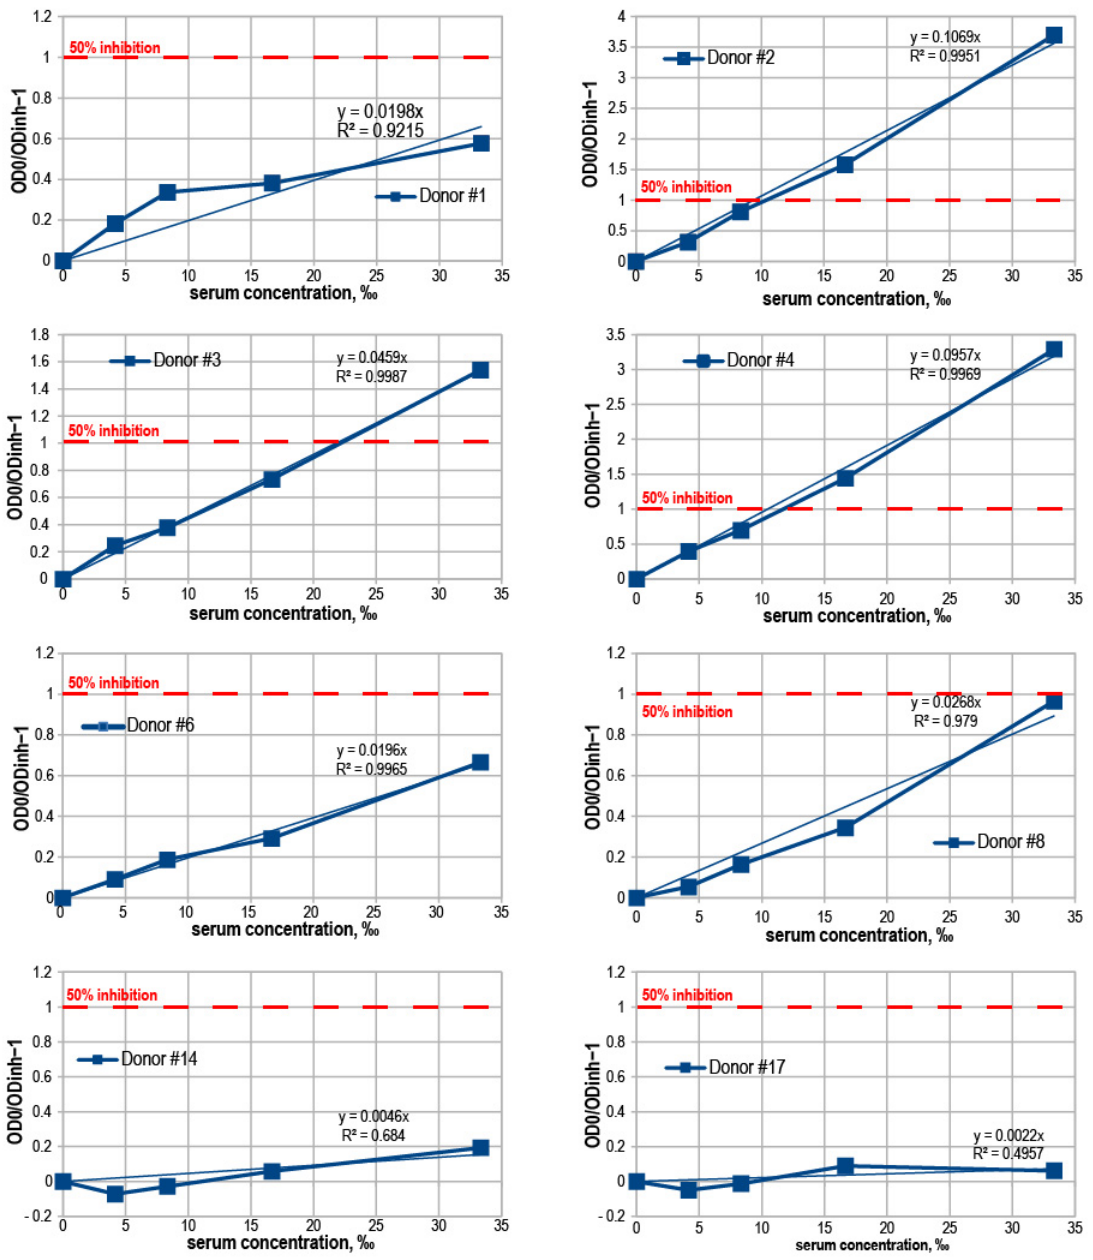
Figure A2. Concentration—inhibition relationship plots for sVNT, eight representative donor serum samples.